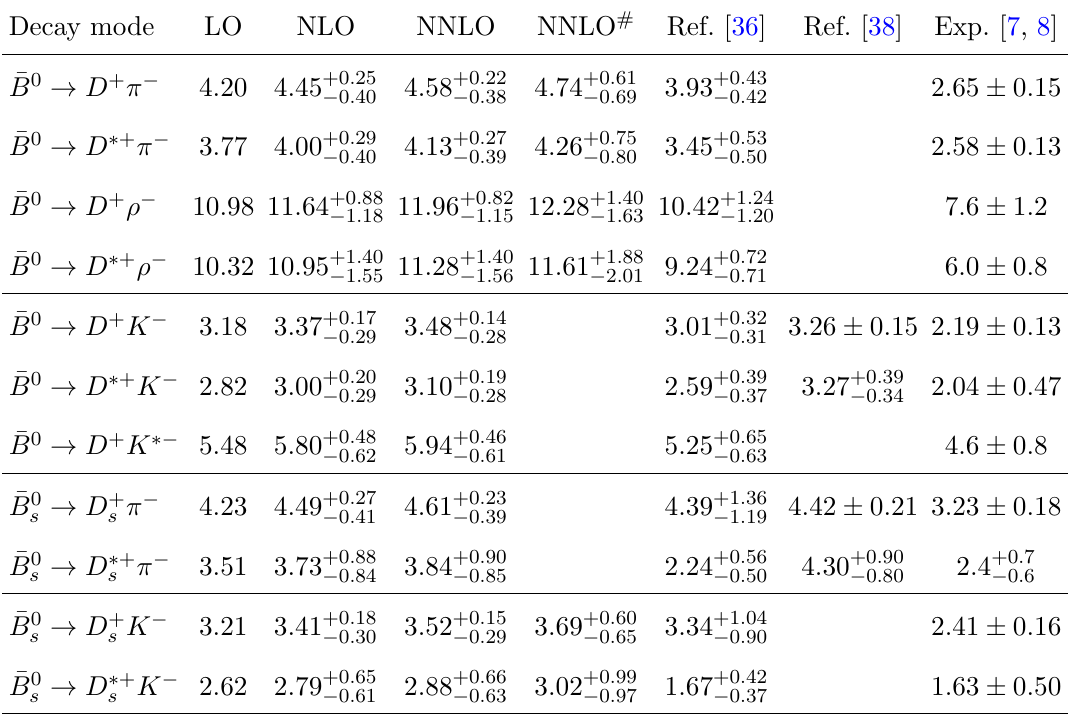
Table 3 . Updated SM predictions for the branching ratios (in units of 10 − 3 for b → c ¯ ud and 10 − 4 for b → c ¯ us transitions) of ¯ B 0 → D ( ∗ )+ L − decays at different orders in α s , together with the results ( s ) ( s ) obtained in refs. [36, 38] as a comparison. The column marked by NNLO # represents our results obtained with the weak annihilation contribution included. For the channel ¯ B 0 → D ∗ + ρ − , only the longitudinal polarization amplitude is considered. The experimental data is taken from refs. [7, 8], with the longitudinal polarization fraction of ¯ B 0 → D ∗ + ρ − decay taken from ref. [87]. For the decay modes ¯ B 0 → D + π − and ¯ B 0 → D + K − , the previous LHCb results have been s s s s